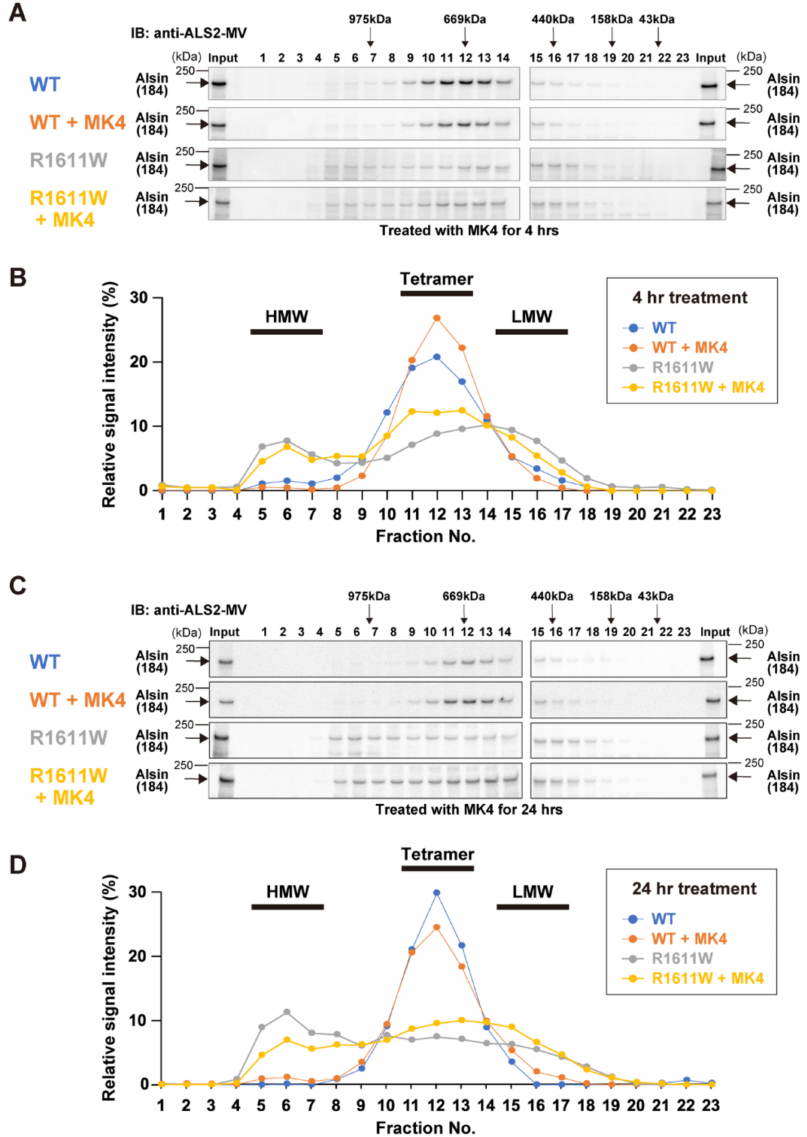
Figure 8. Gel filtration analysis of the wild-type alsin and R1611W pathogenic mutant. HeLa cells were transfected with pCIneoFLAG-ALS2 WT or pCIneoFLAG-ALS2 R1611W . After 24 h, the cells were treated with MK4 for 4 h ( A , B ) or 24 h ( C , D ). Then, the cell lysates were applied to Superose 6 10/300 gel-filtration column. Cell lysates (indicated as input) and the fractions were analyzed by Western blotting using anti-ALS2-MV antibody ( A , C ). Arrows indicate the positions of molecular mass markers. ( B , D ) Quantitative analysis of signal intensities of alsin molecules. Each fraction was expressed as a percentage of the total amount of signals representing ALS2 across the entire fractions. ( B , D ) Positions of high-molecular weight (HMW) complex, tetramer, and low-molecular weight (LMW) complex are